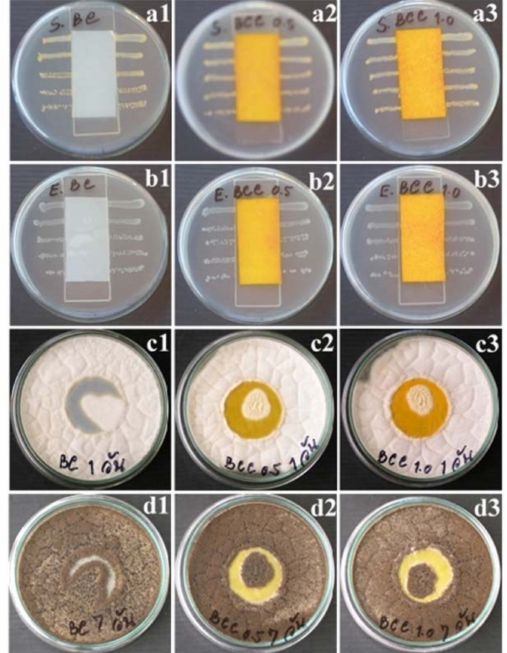
Figure 6. Antimicrobial activities of BC (column 1 ), BCC-0.5 (column 2 ), and BCC-1.0 (column 3 ) against E. coli (row “ a ”), S. aureus (row “ b ”), A. niger after 1 day-incubation (row “ c ”) and A. niger after 7-day incubation (row “ d